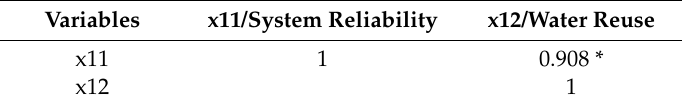
Table 15. CA about the 3rd component of Scenario 02 by SPSS